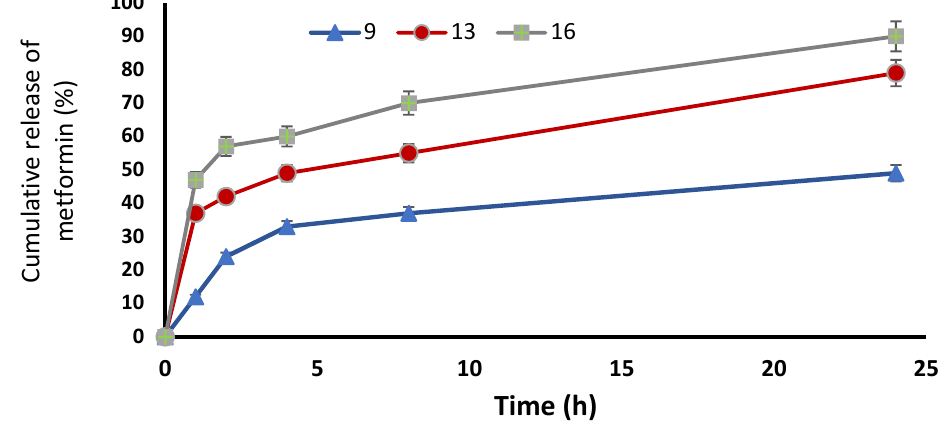
Figure 3. Cumulative release of metformin % from the ethosomal formulations #9, #13 and #16.